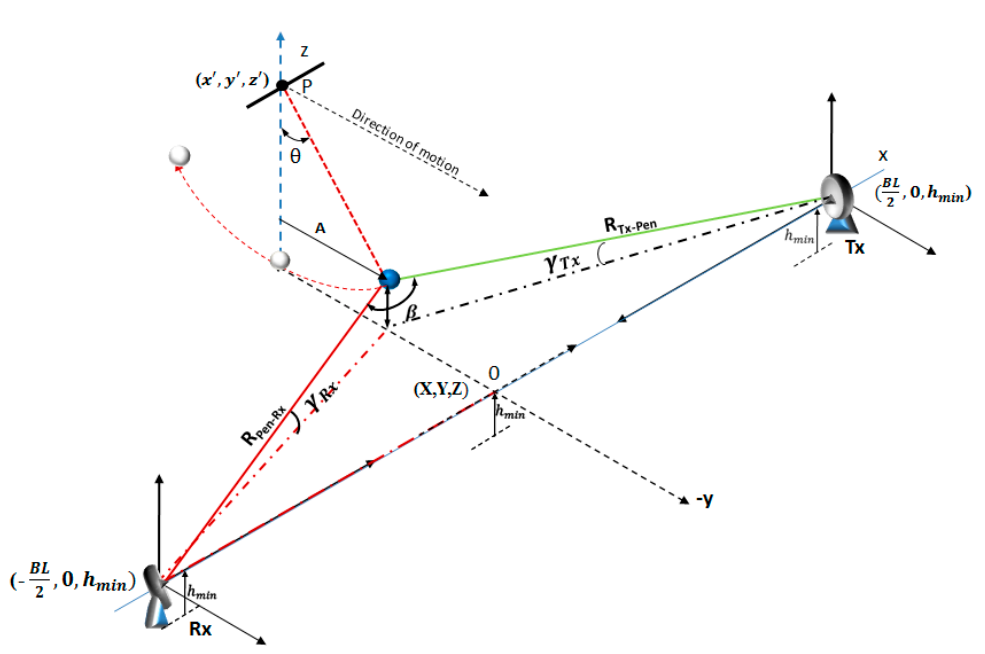
Figure 4. FSR geometry of forward-shifted pendulum with moving pivot point.